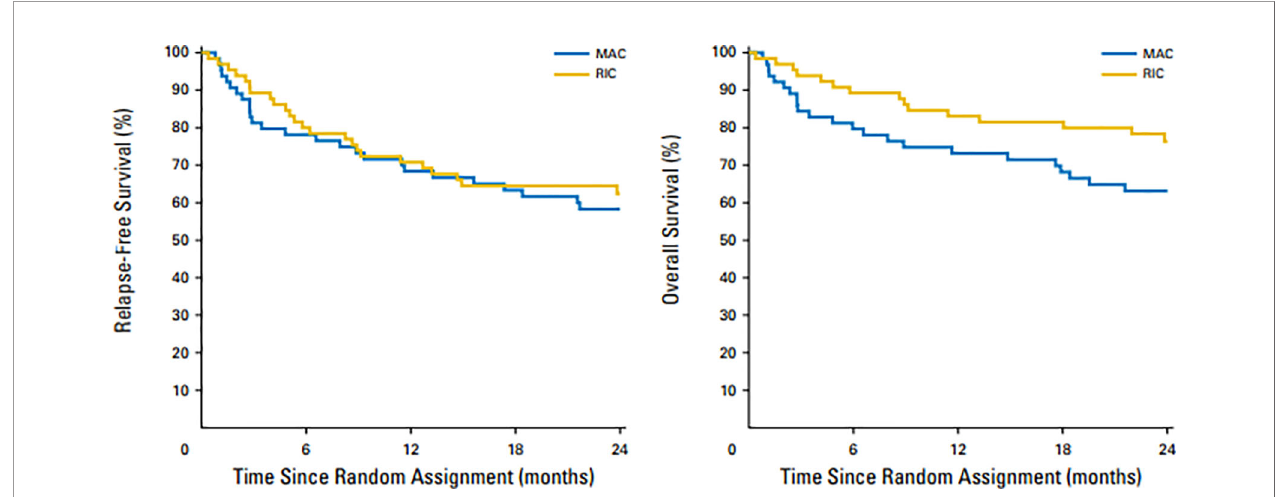
FIGURE 2 | Overall survival and relapse-free survival after 2 years in patients treated with MAC and RIC regimens. Similar OS (left panel) and RFS (right panel) were observed with RIC vs MAC regimens.